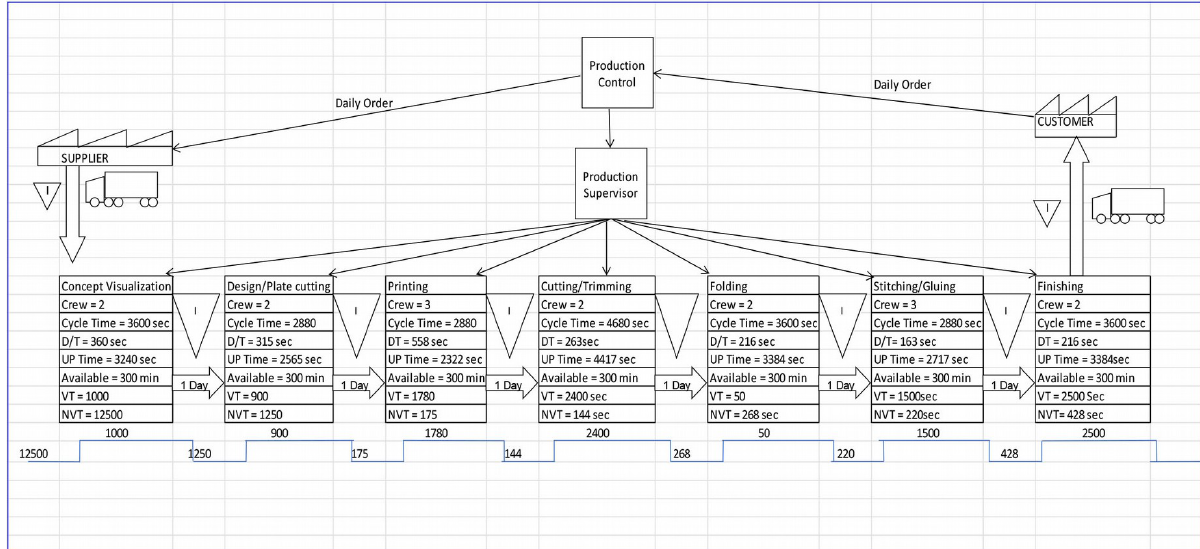
Figure 6. Improved Value Stream Mapping of AB Production